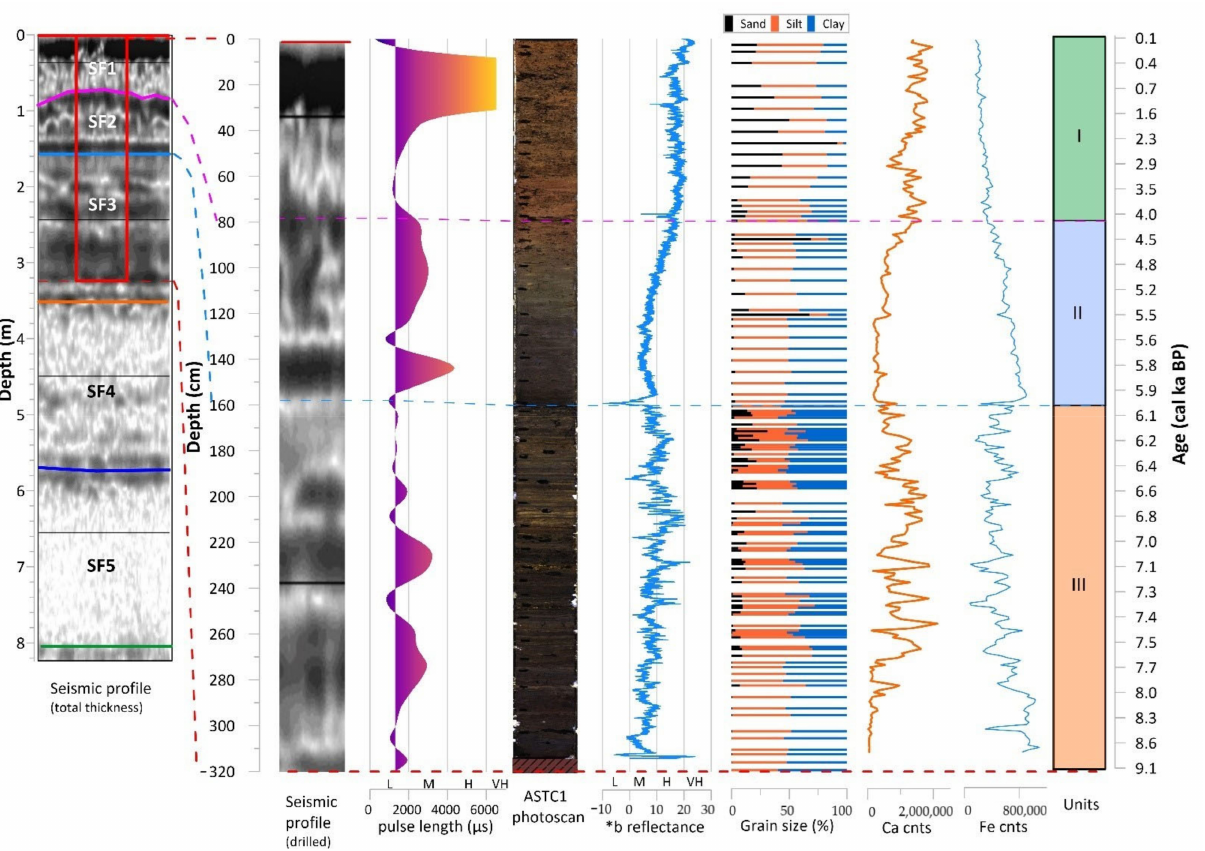
Figure 6. Correlation diagram between seismic ( left ) and lithostratigraphic units of ASTC1 sediment core ( right ). The seismic profile (total thickness) includes the core position and the different seismic facies, SF1–SF5, based on the pulse length. The lithological units are defined on the downcore *b color reflectance record, the grainsize, Ca, and Fe XRF counts. The calendar ages of the sediment core obtained in this study have been assigned to the depth